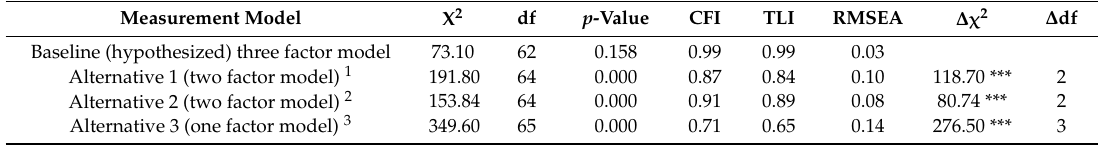
Table 2. Model fit statistics for measurement models.